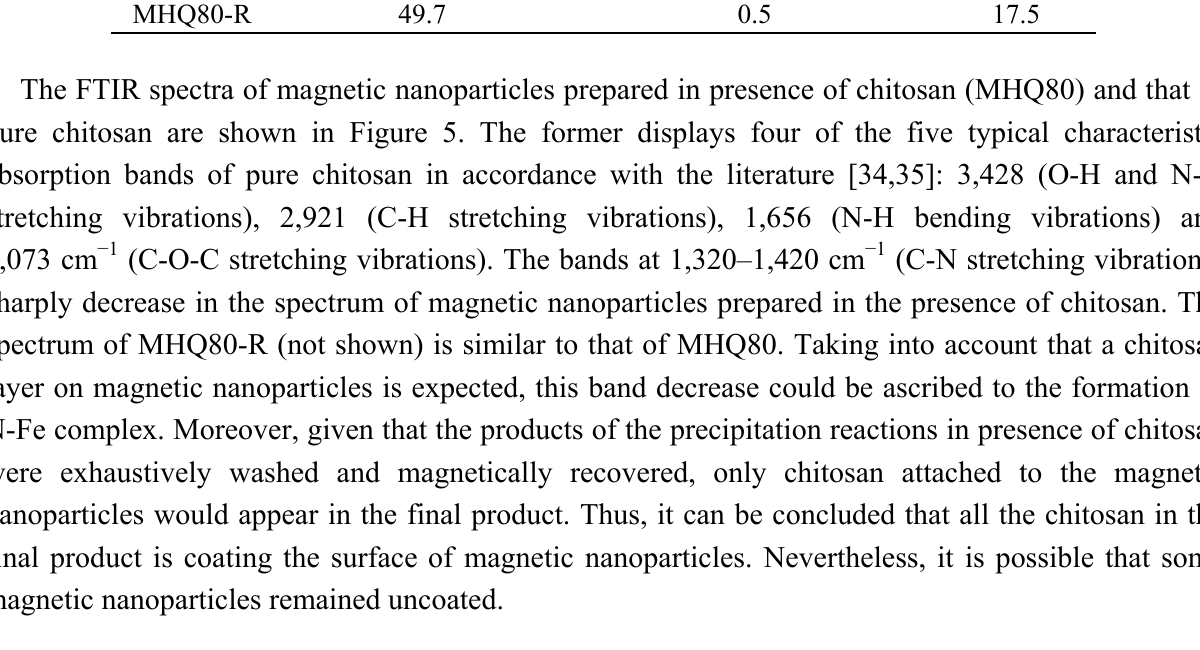
Figure 5. FTIR spectrum of chitosan-coated magnetic nanoparticles (MHQ80) prepared by microemulsion precipitation ( a ). Chitosan spectrum is also included ( b